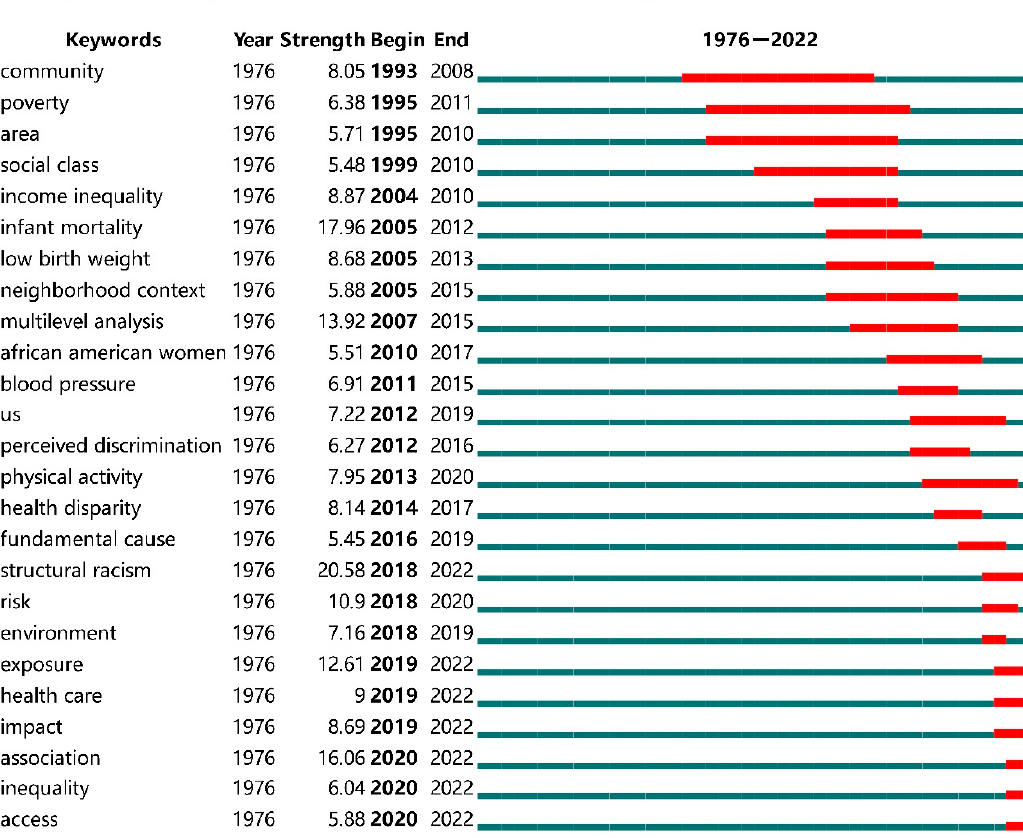
Figure 7. Top 25 keywords with the strongest citation bursts of RSH research from 1976 to 2022.